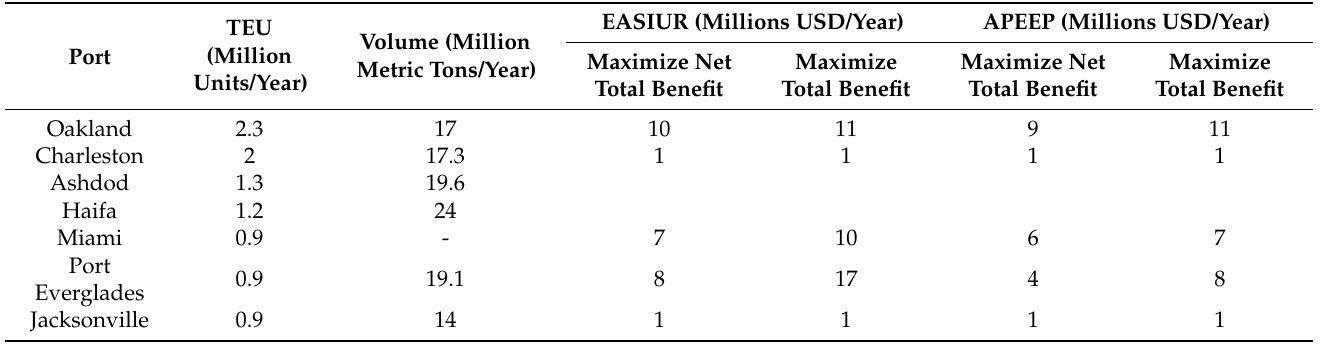
Table A32. Estimated benefits of ESP based on various case studies (based on